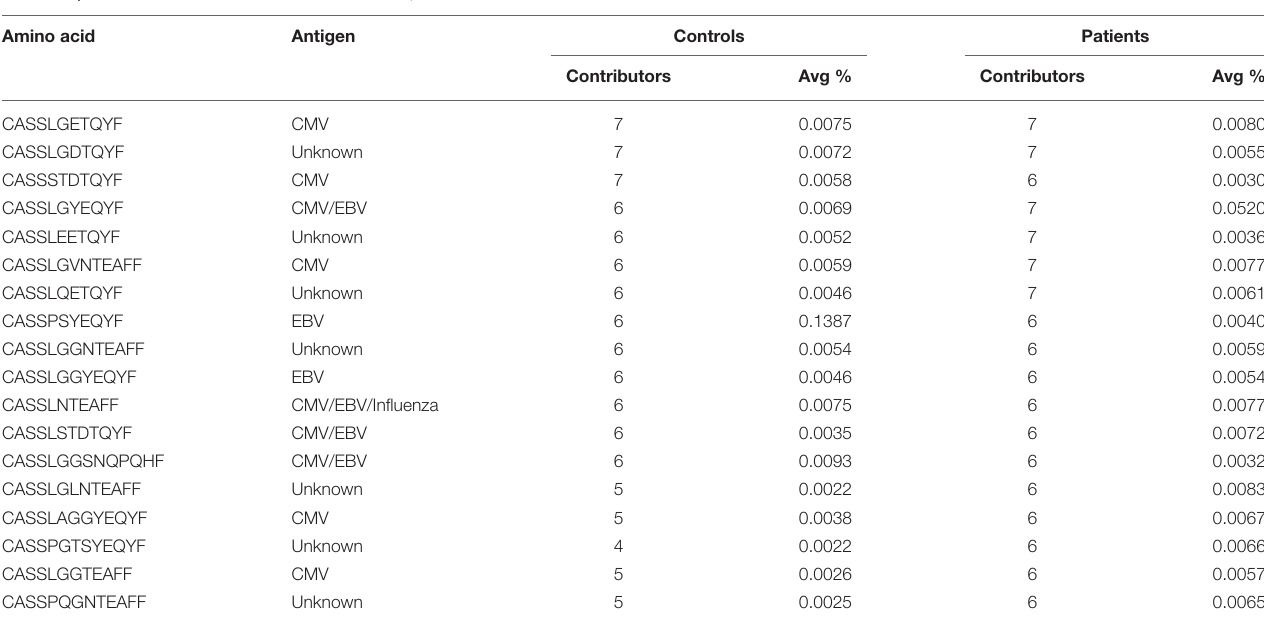
TABLE 5 | Shared T cell clones between controls and patients. Amino acid